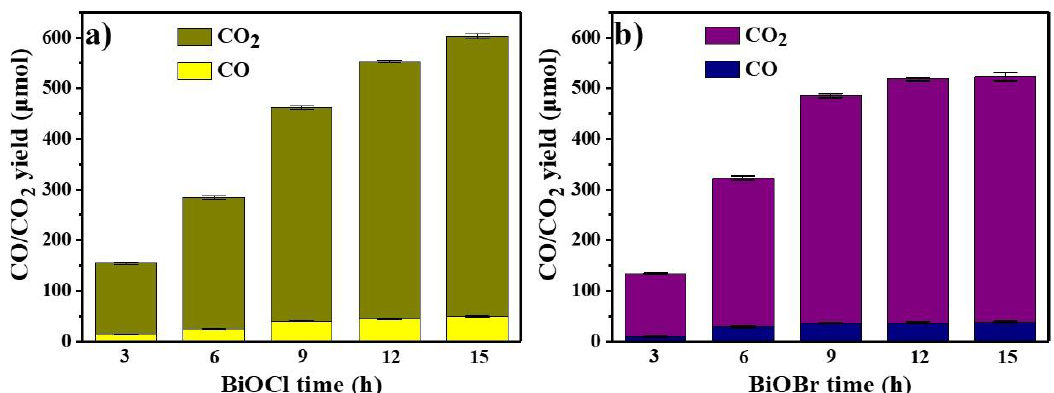
Figure 8. Effect of illumination time on the yield of CO/CO 2 produced by photocatalysis of lignin by BiOCl ( a ) and BiOBr ( b ).